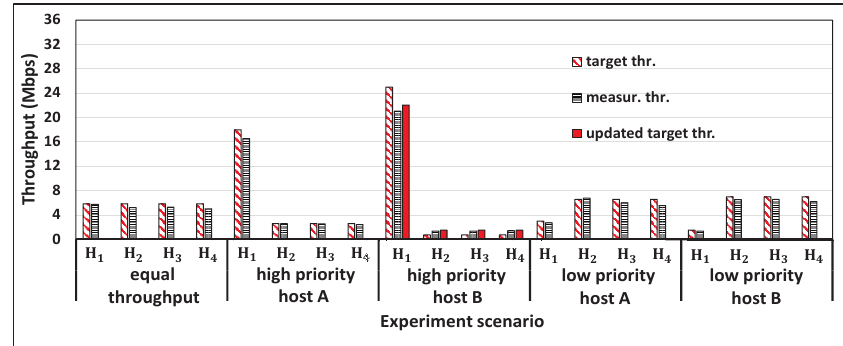
Figure 8. Results for four hosts case with a proposal.